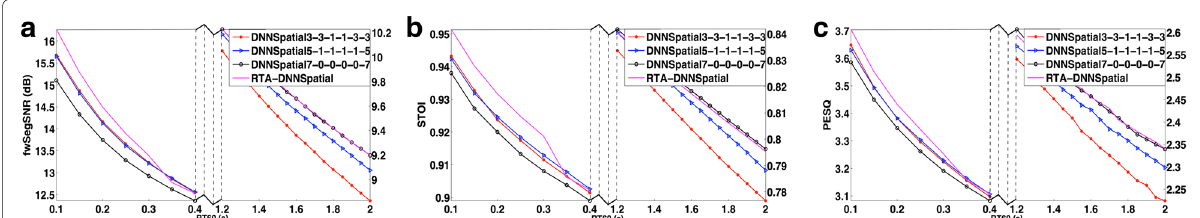
Fig. 9 Average 6-microphone fwSegSNR ( a ), STOI ( b ) and PESQ ( c ) results at different RT60s